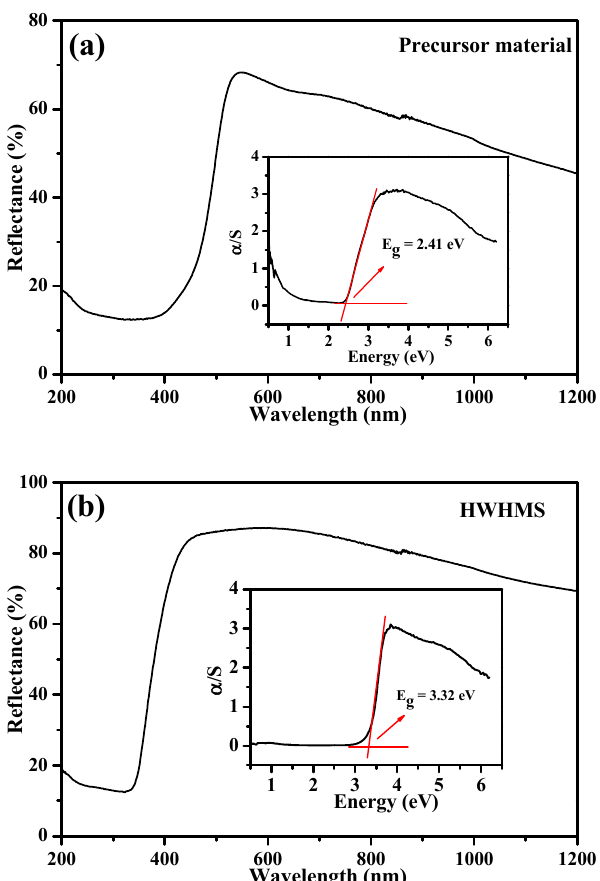
Figure 5. UV–Vis absorption spectrum and calculated band-gap diagram of ( a ) the precursor material and ( b ) the HWHMS.